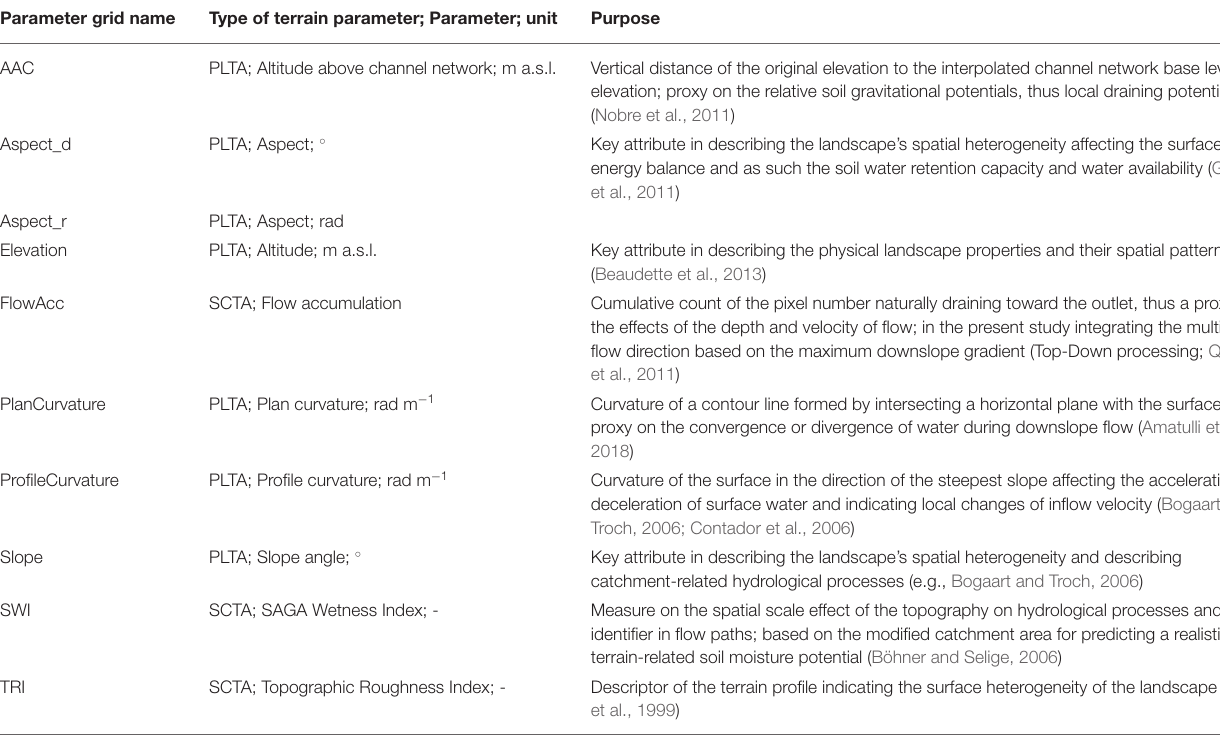
TABLE 4 | Ten terrain parameters as used as predictors in θ NovSAR + Terrain